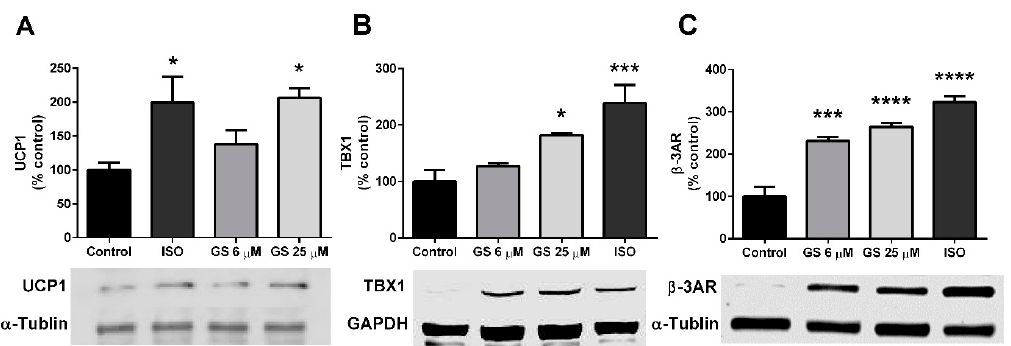
Figure 4. GS treatment increases markers of beiging in 3T3-L1 adipocytes. GS treatment upregulates markers of beiging, including UCP1 ( A ), TBX1 ( B ), and β -3AR ( C ) proteins. Data presented as mean ± SEM from n = 4 replicates per group. * p < 0.05, *** p < 0.001 vs. control. Abbreviations: isoproterenol (ISO), uncoupling protein 1 (UCP1), glyceraldehyde 3-phosphate dehydrogenase (GAPDH), T-box protein 1 (TBX1), β -3 adrenergic receptor ( β -3AR).